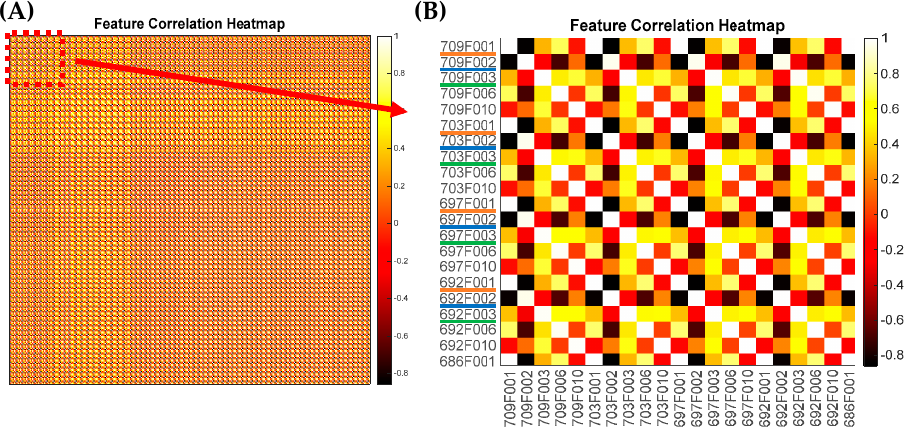
Figure 9. A feature correlation heatmap is presented to demonstrate the correlation between the features across the wavelength: ( A ) shows the overall feature correlation heatmap, whereas ( B ) is the magnified area of the map closely viewing the correlation. The correlation value is between 1 and − 1.